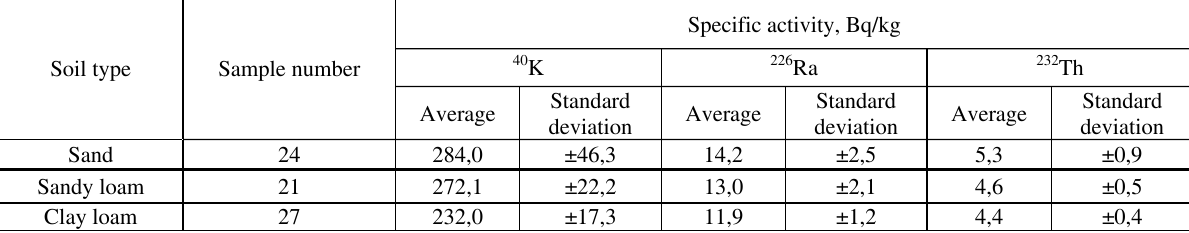
Table 2 . Specific activity of natural radionuclides in different types of soil